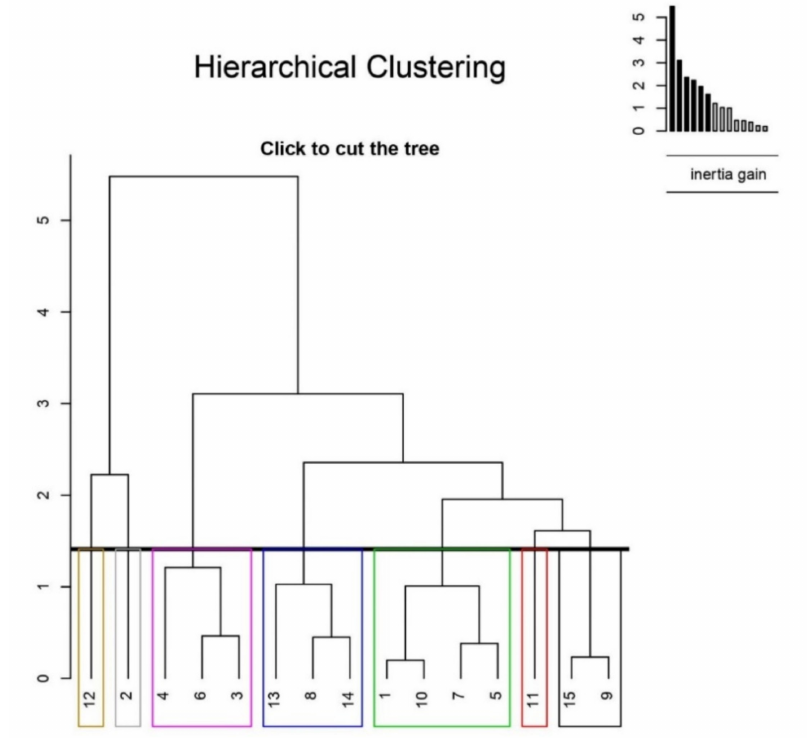
Figure 2. Hierarchical clustering of ECB genotypes (Numbers in different colors 1 to 15 represent the